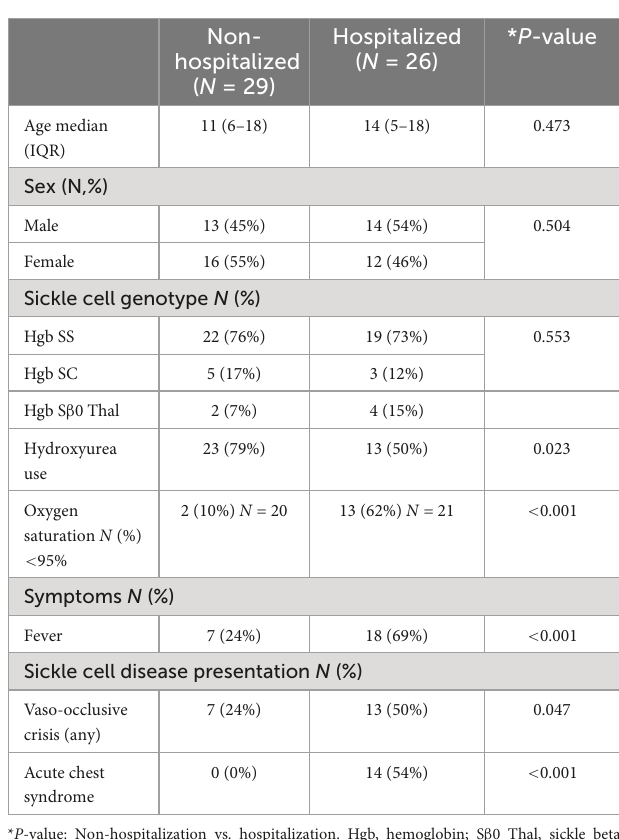
TABLE 4 Sickle cell disease (SCD) COVID-19 patients non-hospitalized vs.